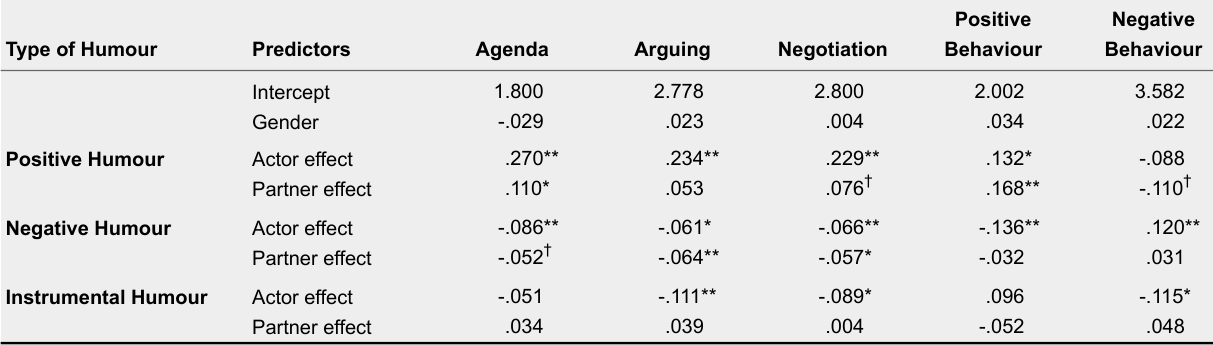
Self-Reported and Observed Behaviour While Discussing Relationship